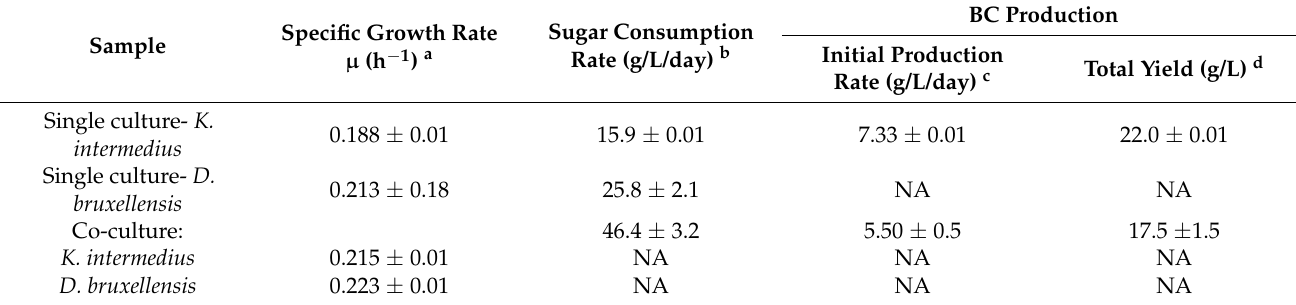
Table 2. Specific growth rate µ (h − 1 ), the sugar consumption rate (g/L/d), initial production rate (g/L/d), and total BC yield (g/L) of K. intermedius (bacteria) and D. bruxellensis (yeast) in single and co-culture.